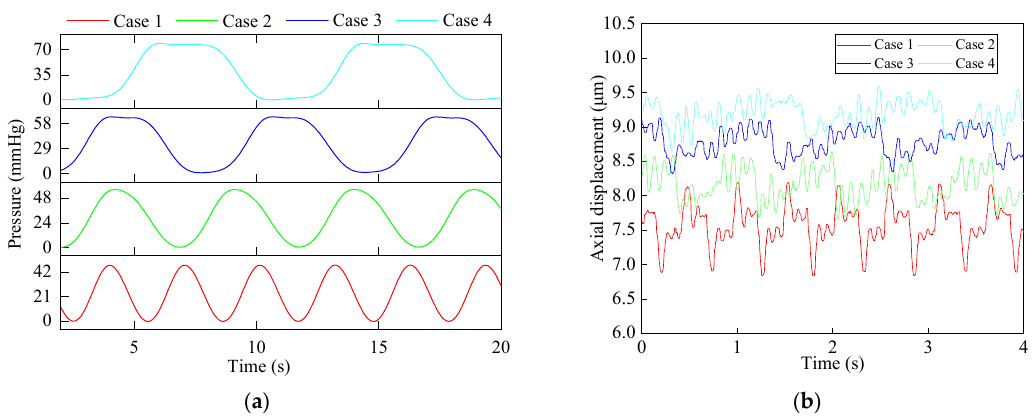
Figure 20. Effects of different external disturbances on suspension performance of the rotor at constant speeds: ( a ) Pressure waveform; ( b ) Axial displacement.